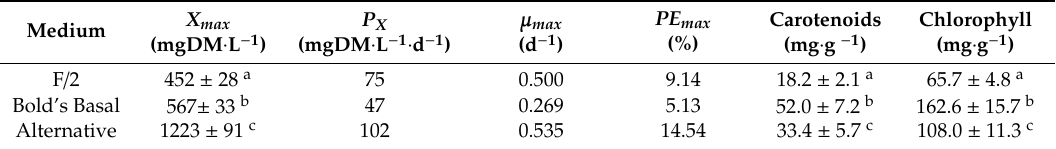
Table 3. Growth parameters and pigments production by Dunaliella tertiolecta (UTEX 999) cultivated in di ff erent culture